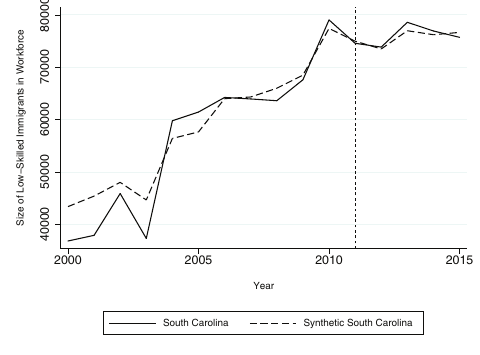
Figure A9 South carolina universal e-verify and size of low-skilled immigrant